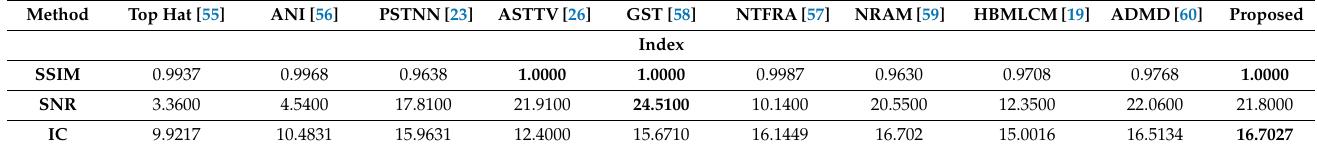
Table 6. Calculation of indicators in scenario B of each model.